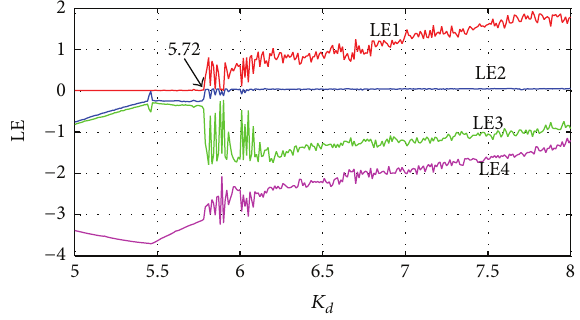
Figure 14: The chaotic attractor with 𝐾 𝑖 = 1 , 𝐾 𝑝 = 2 , and 𝐾 𝑑 = 6.5 .